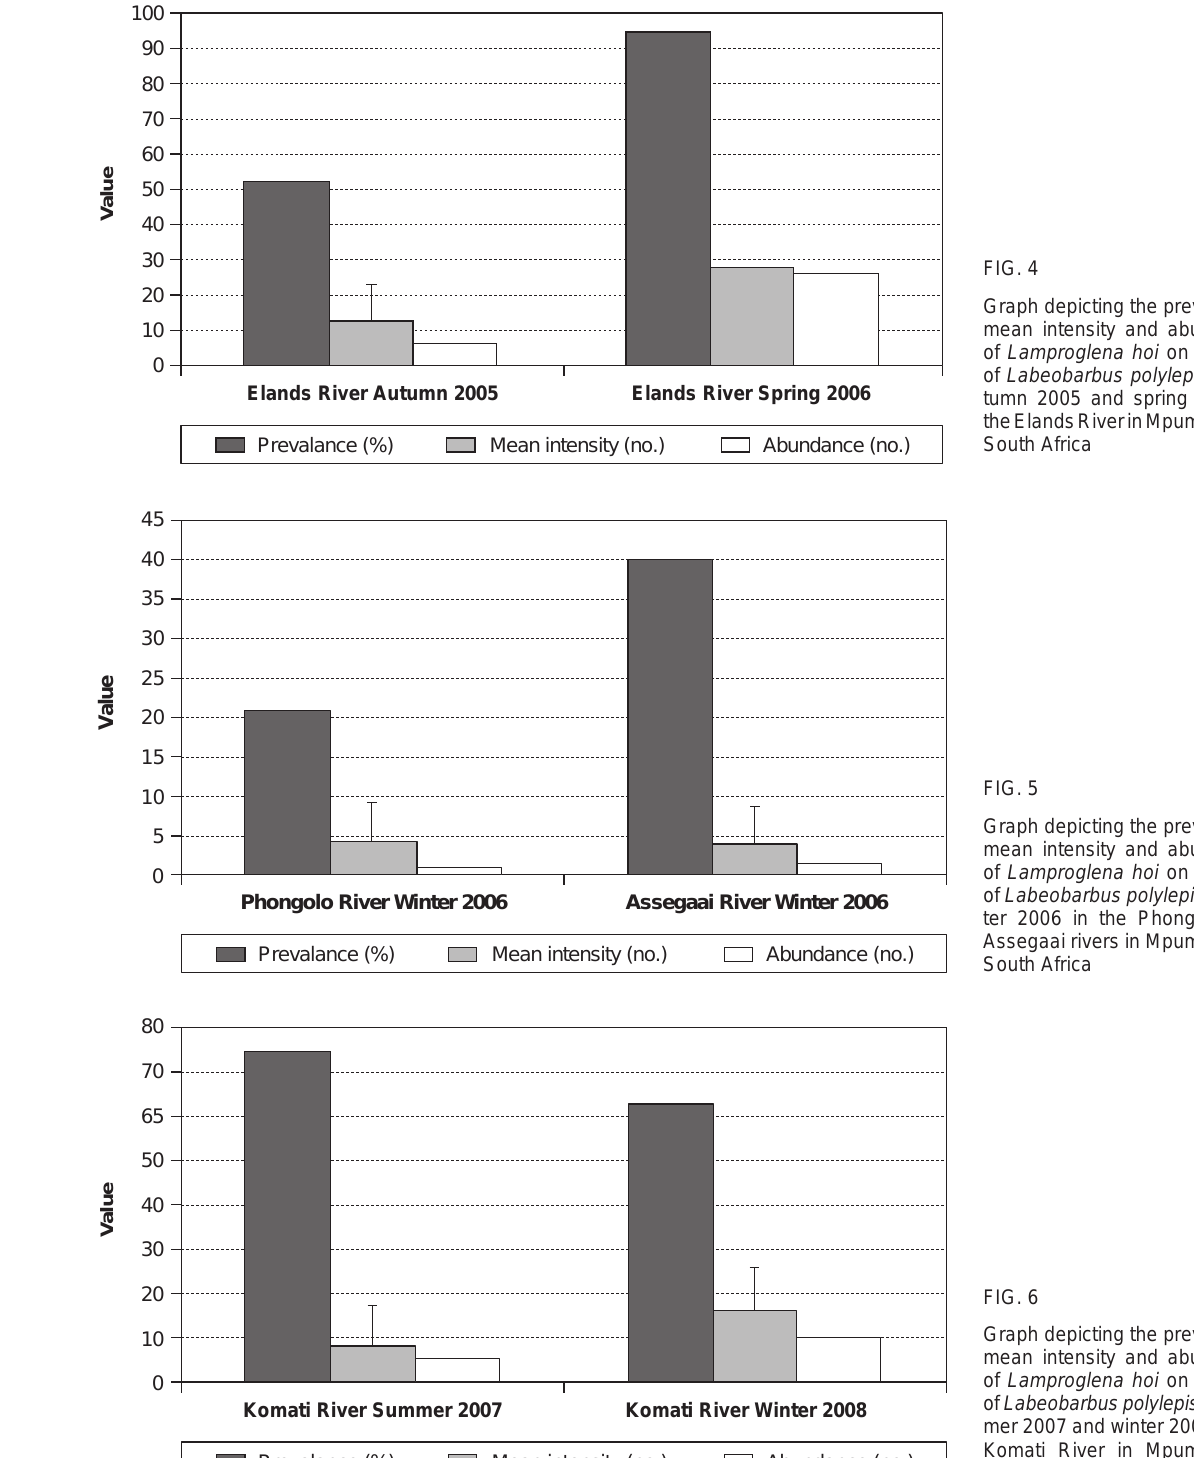
Graph depicting the prevalence, mean intensity and abundance of Lamproglena hoi on the gills of Labeobarbus polylepis in sum- mer 2007 and winter 2008 in the Komati River in Mpu ma langa, South